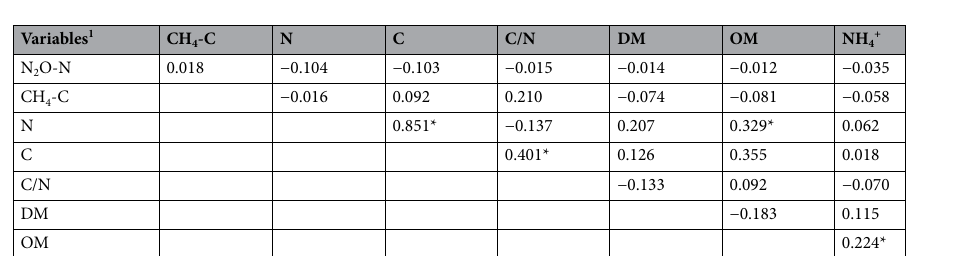
Table 4. Pearson’s correlation coefficients between explanatory variables during the evaluated period. *Represents a statistical significance (P ≤ 0.05) for the coefficients of correlation. Analyses were carried out using data from all evaluated days. 1 DM = dry matter, OM = organic matter, NH 4+ = ammonium.